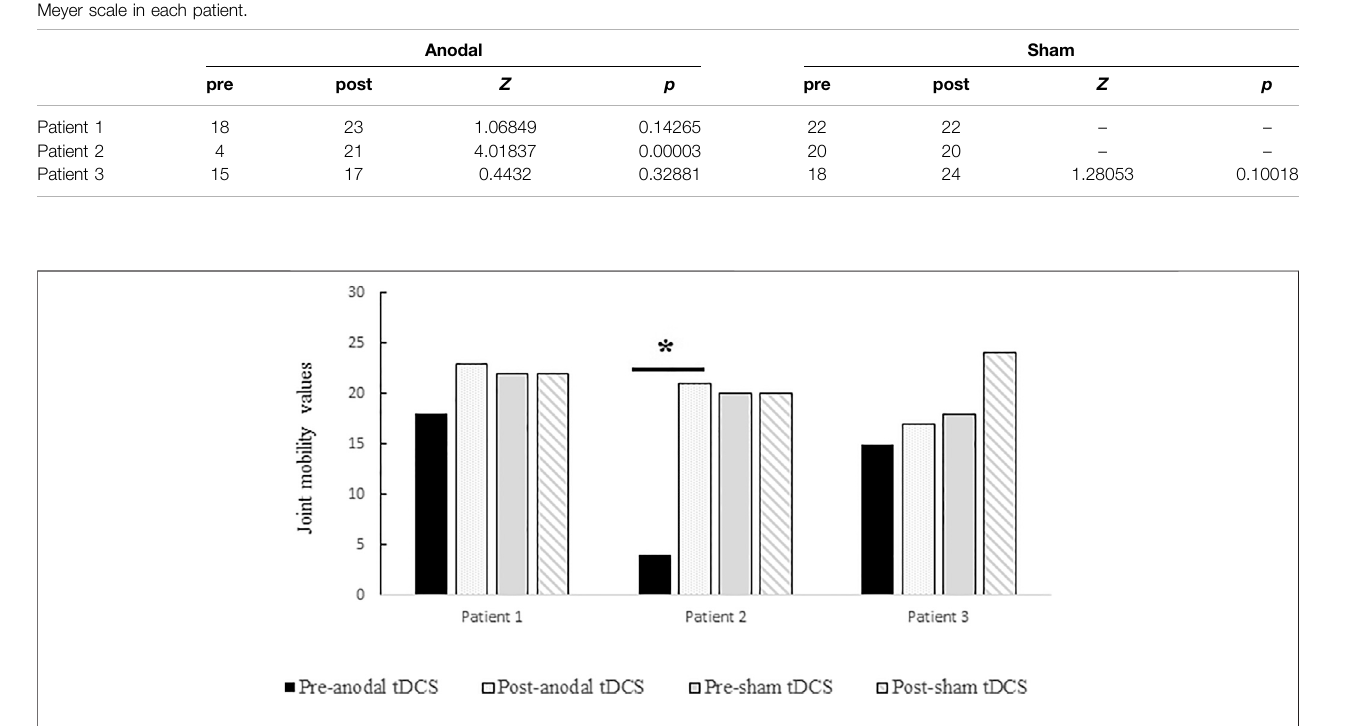
Frontiers in Pharmacology |